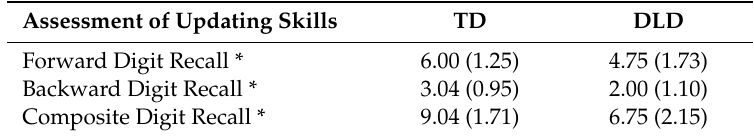
Table 2. Results from the assessment of updating skills. Data are presented as means (and standard deviations, SD). The asterisk (*) shows when the group-related di ff erence was significant.